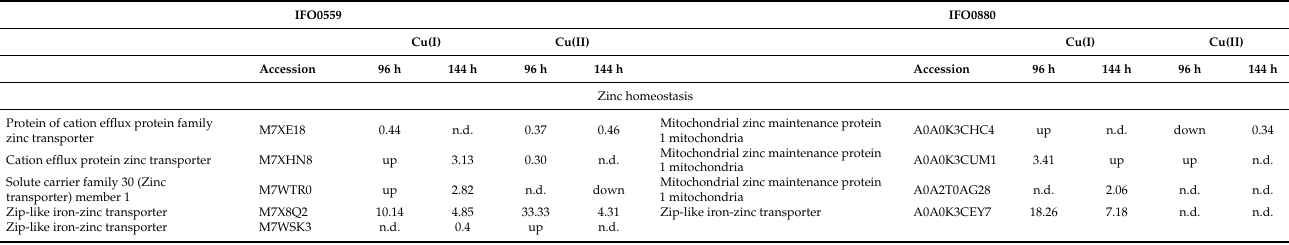
Table 3. Differentially expressed proteins involved in zinc homeostasis discussed here. For IFO0559 and IFO0880, fold change of samples grown under Cu(I) and Cu(II) stress was compared to respective control. Protein names and UniProt accession numbers are listed. Further fold change at 96 h and 144 h of samples are stated. Fractions below 1 depict downregulation. n.d. = not detected; up = upregulated below cut-off score; down = downregulated below cut-off score. Cut-off score: significance ≤ 2 or fold change ≤